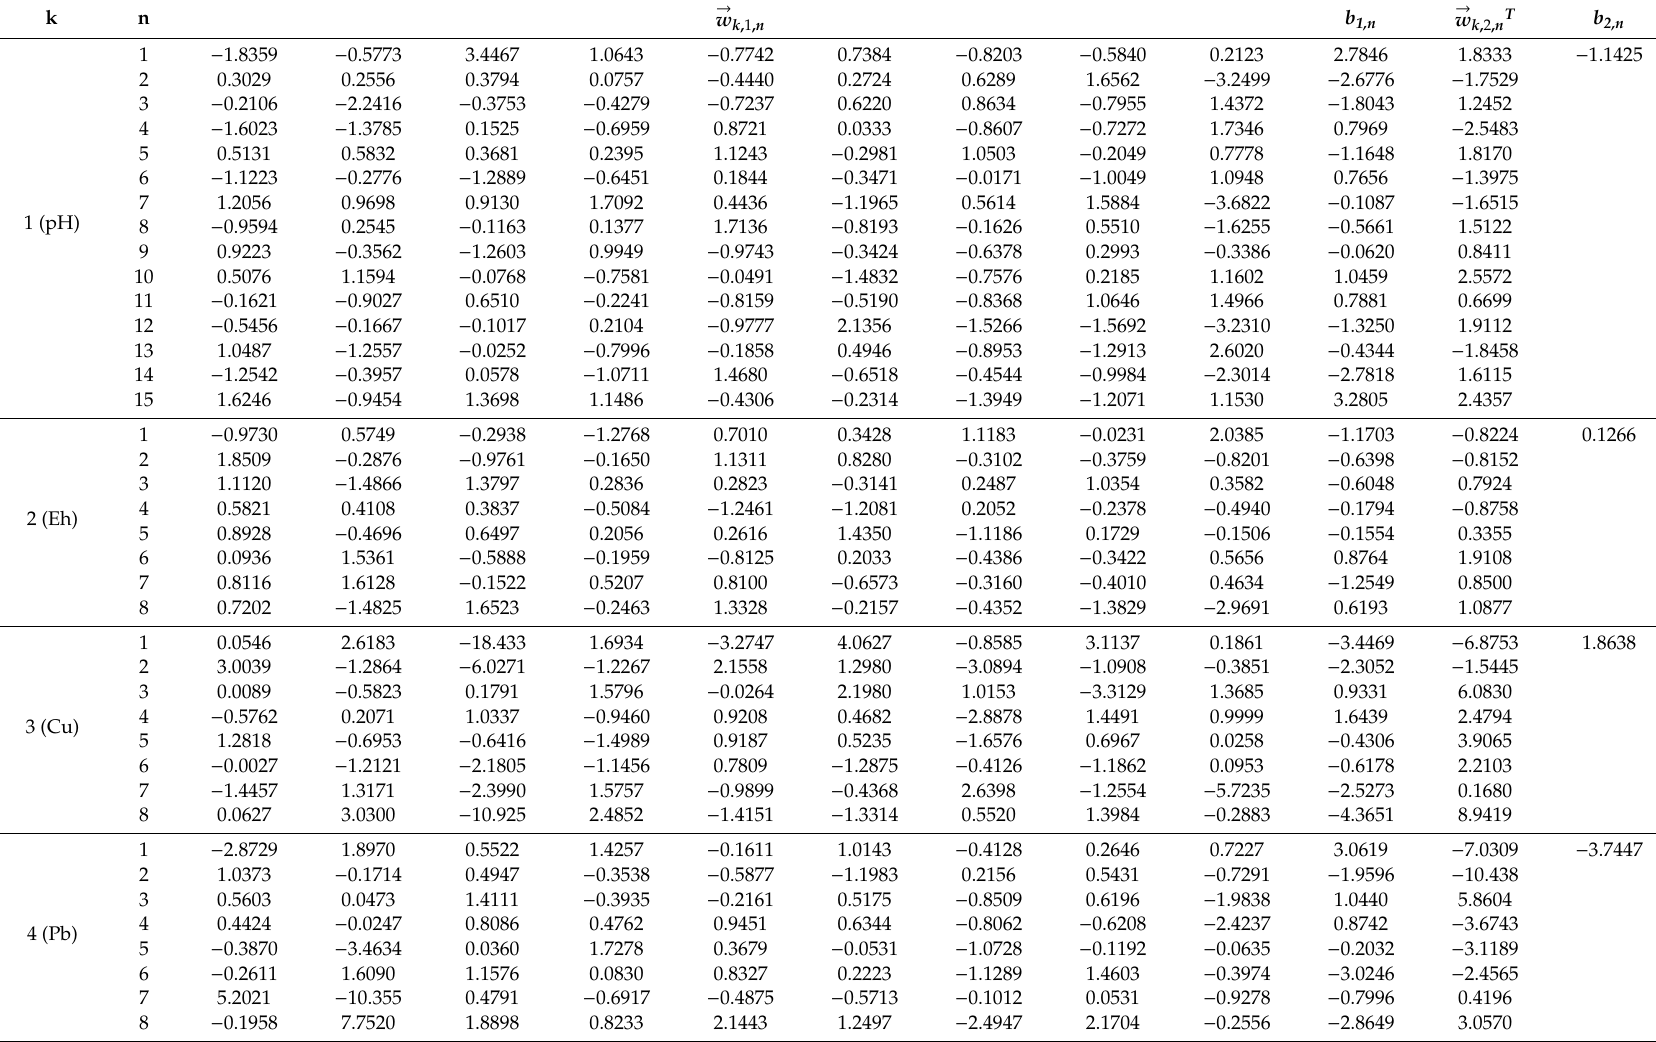
Table 4. w and b matrices of the best topologies for each output